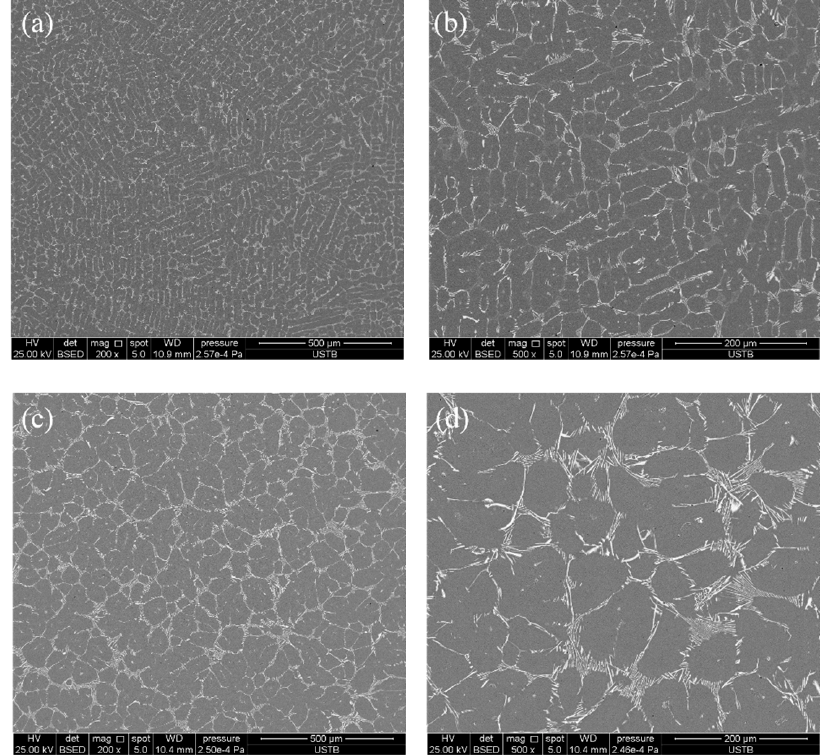
Figure 3. SEM images of HSS solidification structure: ( a , b ) As-cast ingot; ( c , d ) ESR ingot.